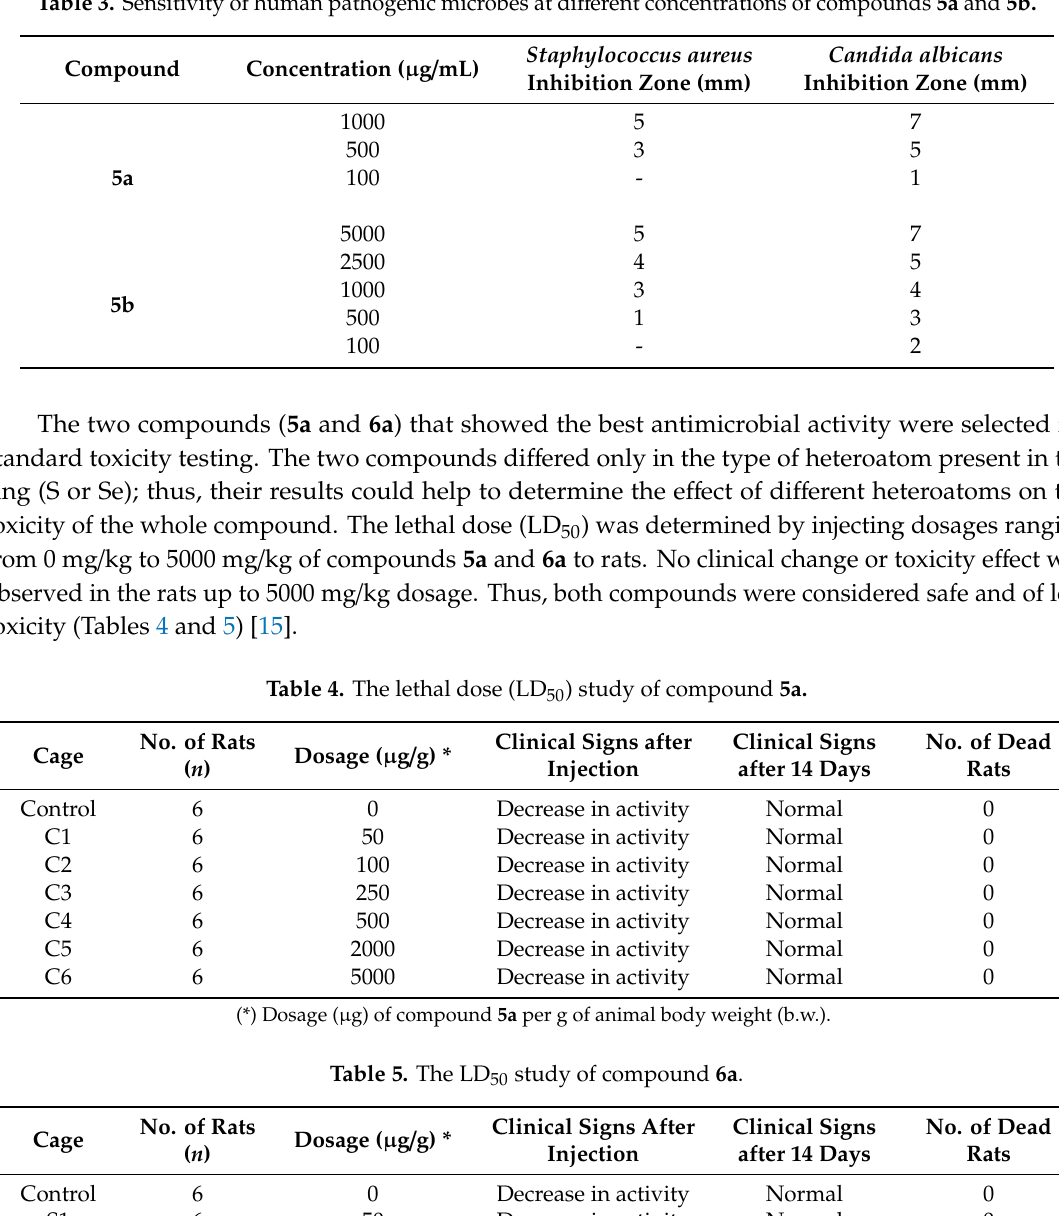
Table 3. Sensitivity of human pathogenic microbes at di ff erent concentrations of compounds 5a and 5b.